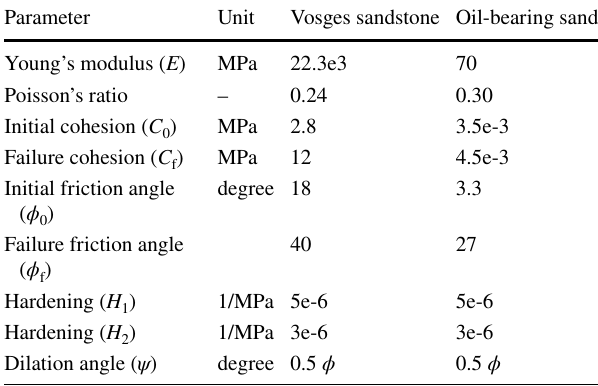
Table 1 Damage model parameters for Vosges sandstone and